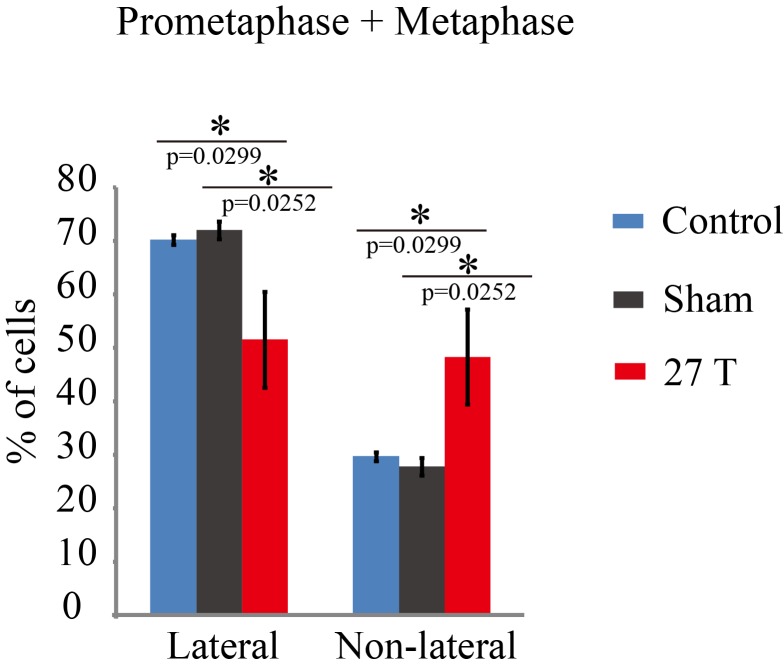
Spindle orientation in prometaphase and metaphase CNE-2Z cells were changed by 27 T SMF.Quantification of spindle orientations in control, sham or 27 T treated cells from four independent experiments (n = 4). Data is presented as mean ± SD. Both prometaphase and metaphase cells were quantified. Total of 1447 spindles were measured. **p<0.01.